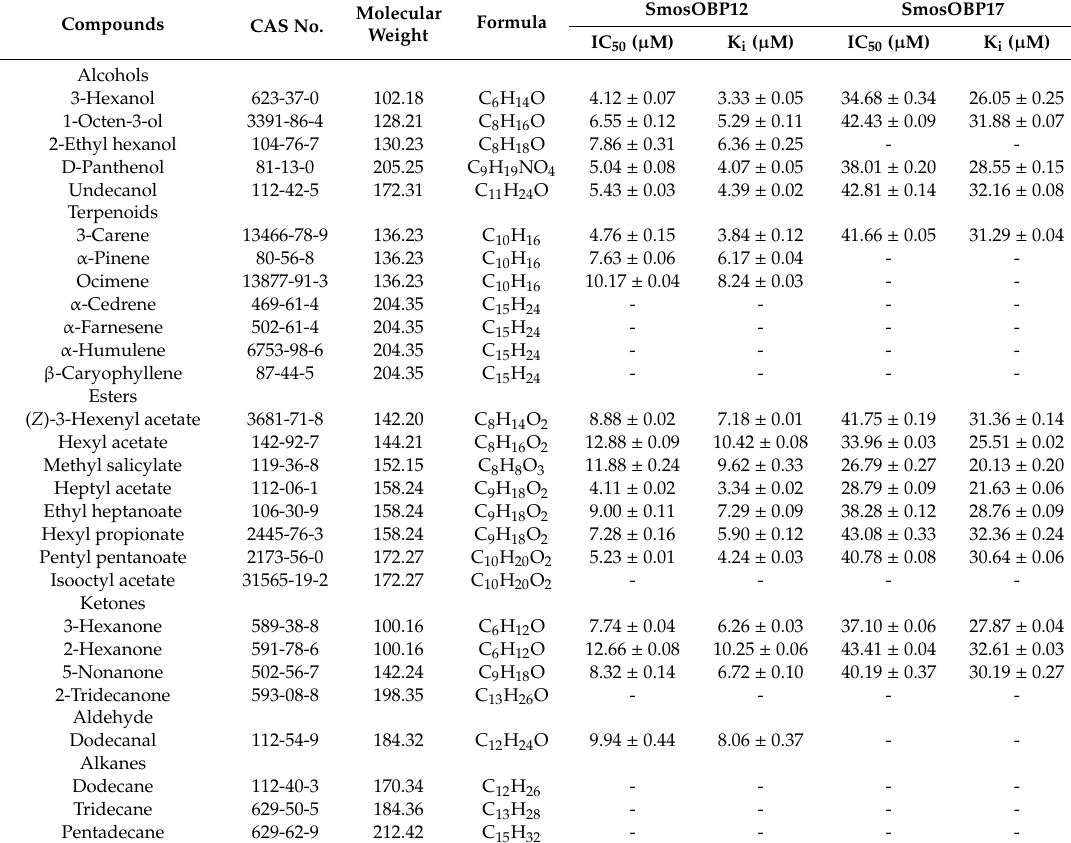
Table2. Bindinga ffi nitiesoftwoSmosOBPstowheatvolatilecompoundsinfluorescencebindingassays. Molecular Compounds CAS No. Weight